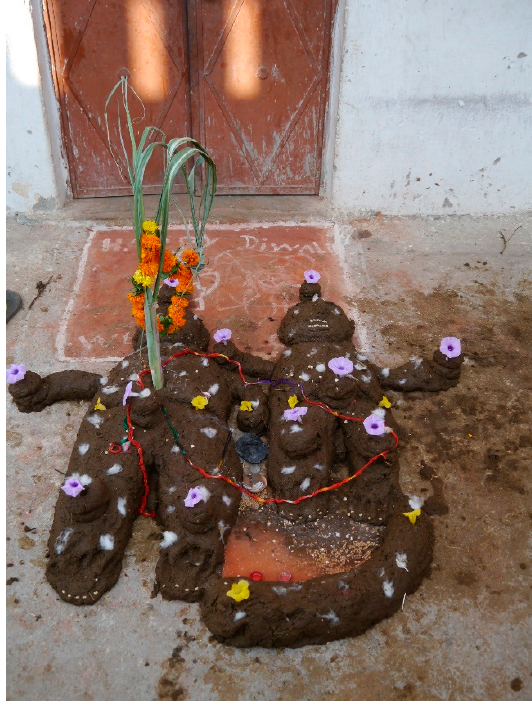
Figure 12. Sugar cane stick in Govardhan’s navel, Badi 2017 (picture by author). Religions 2019 , 10 , x FOR PEER REVIEW